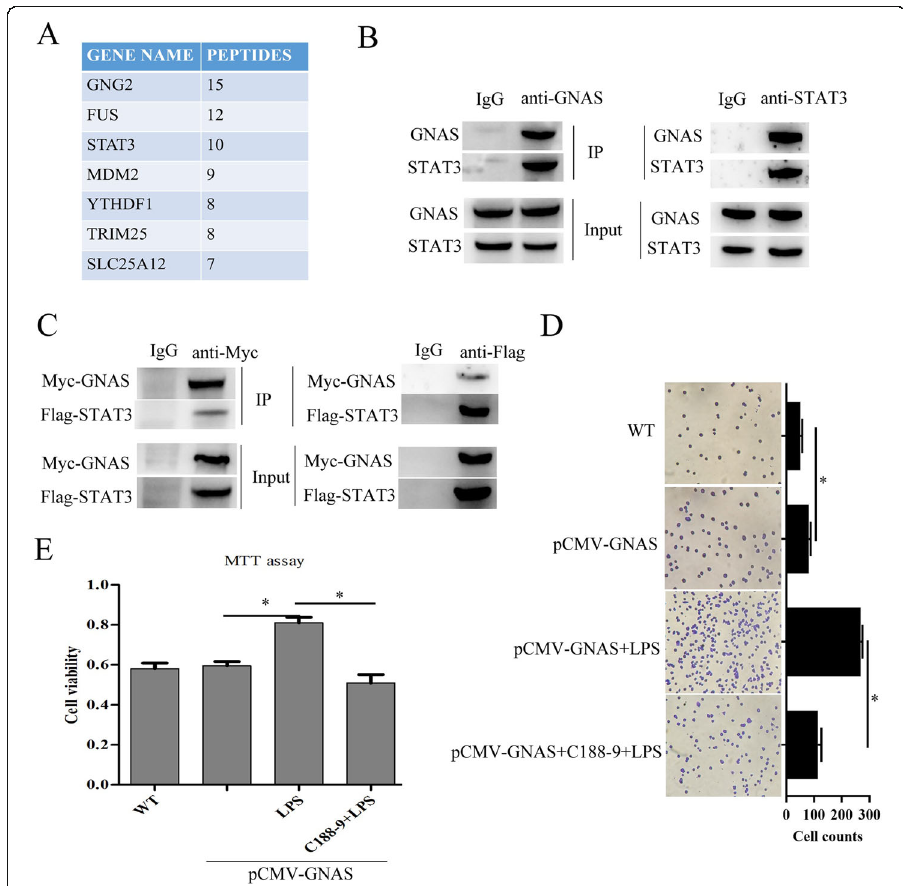
Fig. 5 GNAS promotes LPS-induced HCC cell growth and invasion by interacting with STAT3. a Table listing the GNAS-interacting proteins that coimmunoprecipitated with anti-GNAS antibody from HepG2 cells identified by mass spectrometry. b The interactions of endogenous GNAS and endogenous STAT3 in HepG2 cells were detected by CO-IP. c HepG2 cells were transfected with pCMV-myc-GNAS and pCMV-flag- STAT3 for 24 h, and then the interactions of exogenous GNAS and exogenous STAT3 were detected by CO- IP. d and e HepG2 cells were transfected with pCMV-myc-GNAS for 24 h, treated with a specific inhibitor of STAT3, c188 – 9, for 30 min, and then stimulated with LPS (5 μ g/ml) for 12 h. Cell invasive ability was examined by transwell invasion assays ( d ). Cell proliferation was examined by MTT assays ( e ). Data are represented as means ± SD ( n = 3; * represents P <